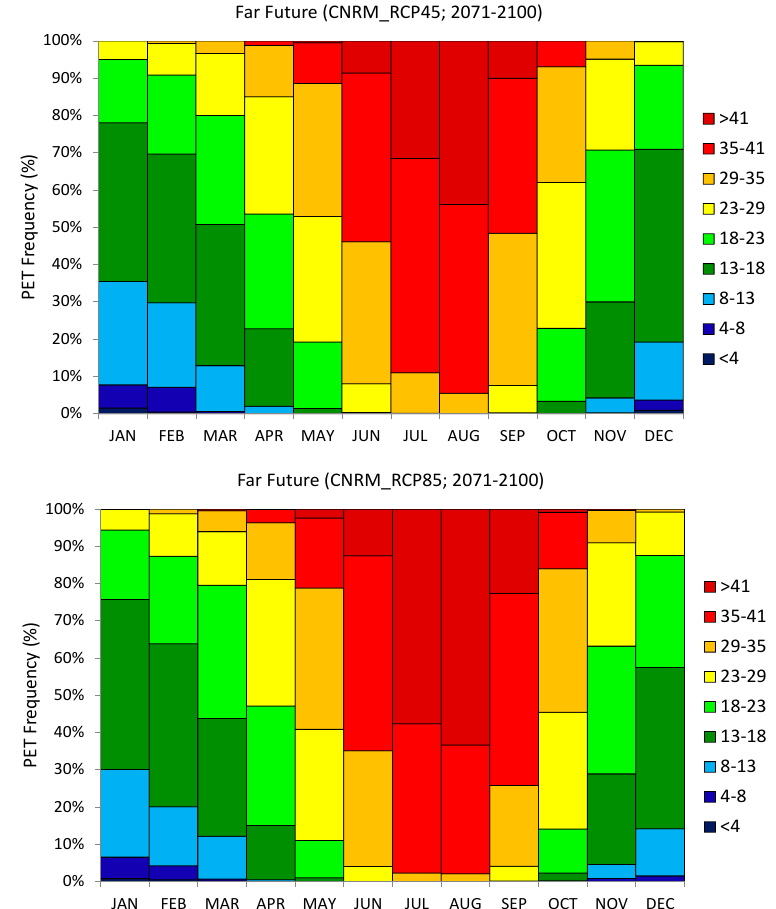
Figure 4. Bioclimate diagram for Milos island, indicating PET frequency (%) per month, for the far future 2071–2100, based on CNRM regional climate model for two Representative Concentration Pathways, RCP4.5 (upper graph) and RCP8.5 (lower graph).